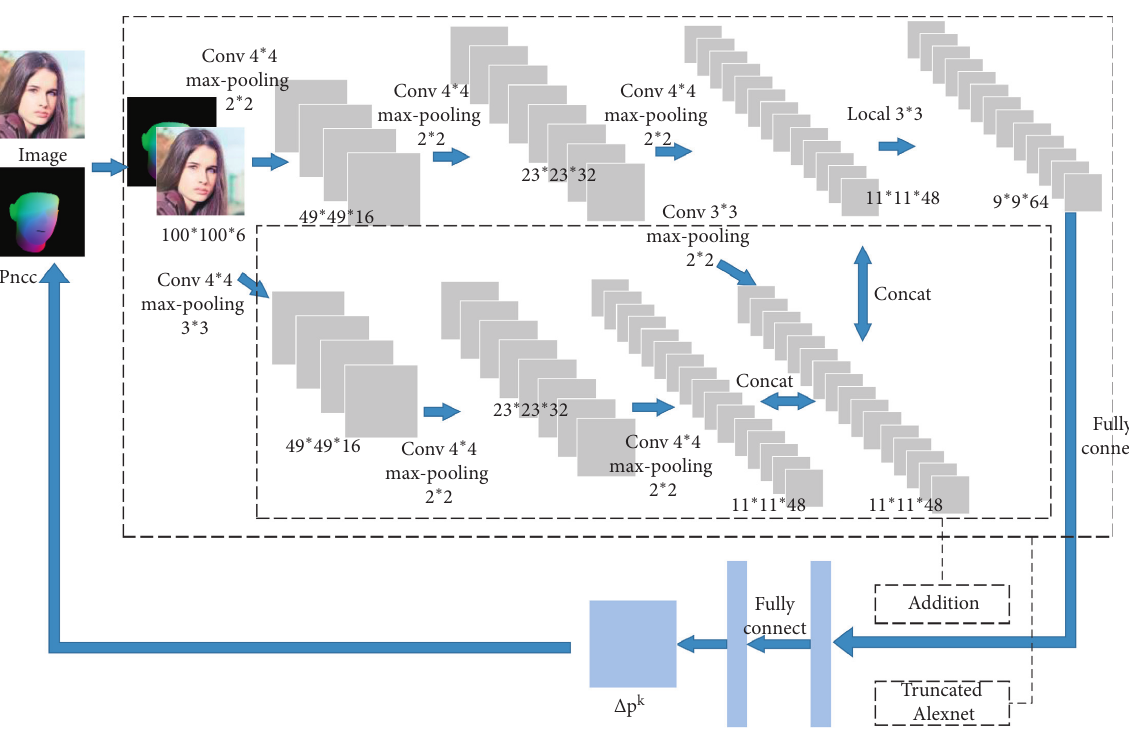
Figure 3: Cascade network structure based on truncated